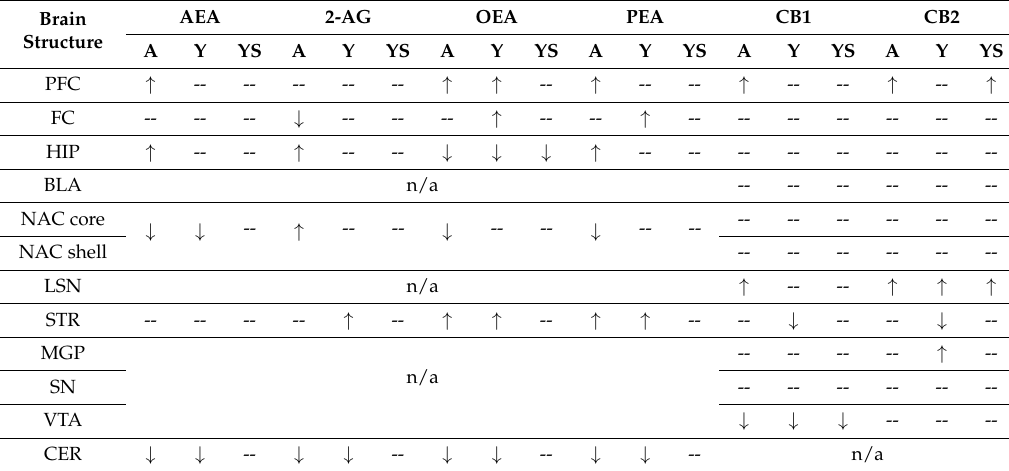
Table 1. Changes in the endocannabinoid, NAE (tissue levels), and cannabinoid receptors (CB1 and CB2) in the selected rat brain structures during cocaine-induced